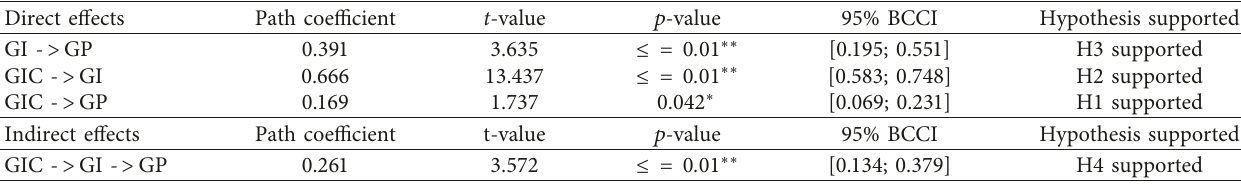
Table 7: Results of the structural model for the mediation model.